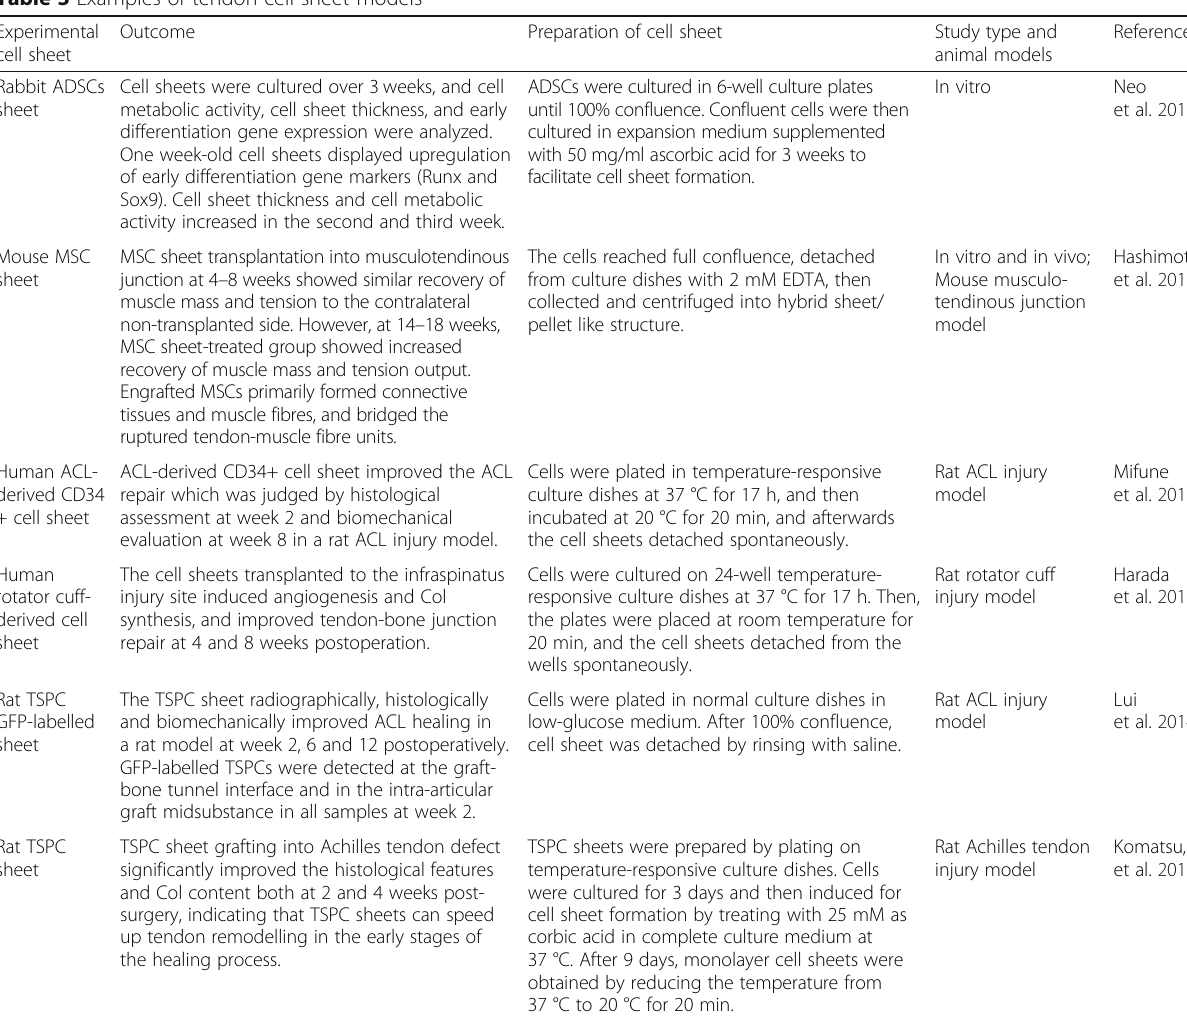
Table 3 Examples of tendon cell sheet models Experimental Outcome Preparation of cell cell sheet